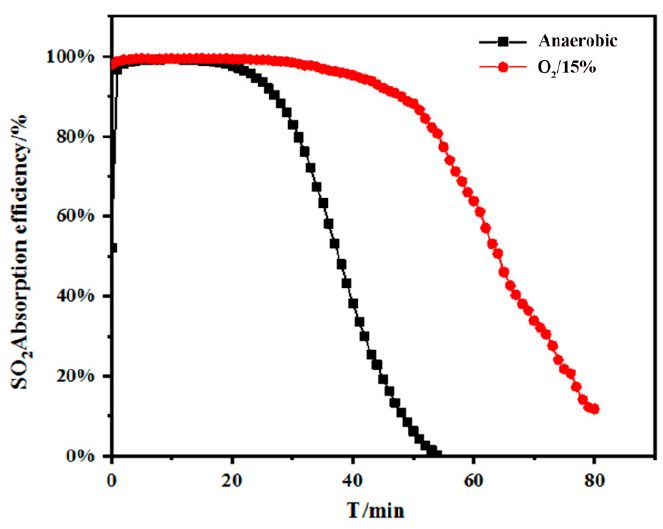
Figure 8. Effect of O 2 . SO 2 = 2300 ppm, gas flow = 1.68 L/min, absorption solution = 60 mL, Ci-Na = 0.06 mol/L and HA–Na = 0.2 g and 25 ° C.